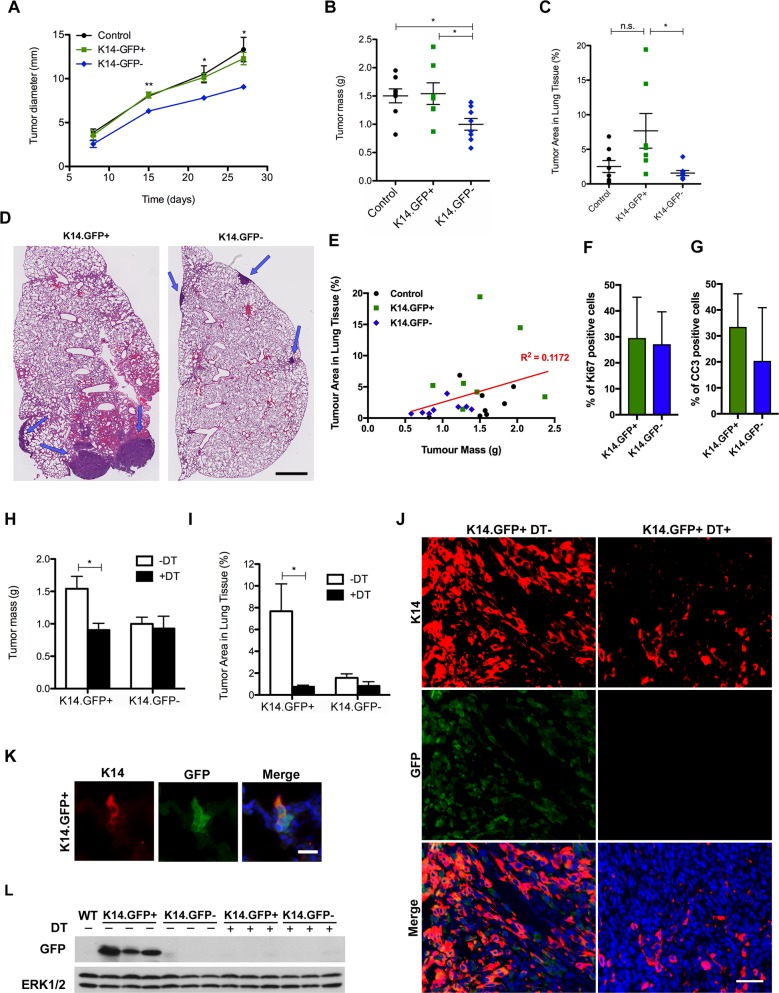
K14.GFP+ cells have greater metastatic potential that K14.GFP− cells in vivo.(A) Primary tumor diameters from mice injected with 4T1 control, or K14.GFP reporter cell lines (K14.GFP+ or K14.GFP−), measured over the course of the experiment. n = 8 (control), 7 (K14.GFP+), and 8 (K14.GFP−); *p < 0.05, **p < 0.001 by one-way ANOVA followed by Newman-Keuls multiple comparisons posttest. (B) Final tumor masses measured after mice were euthanized. (C) Lung metastases were quantified by measuring the average percent area of lung tissue occupied by the tumor in 5 sections (5-μm thick) cut at 200-μm intervals. (D) Representative images of H&E-stained lung sections containing metastases from mice injected with K14.GFP+ or K14.GFP− cell lines. Arrows indicate metastasis; scale bar 1 mm. (E) Correlation analysis of primary tumor mass and lung metastasis. Scatter plot of the percent tumor area in lung tissue compared to the primary tumor mass for each mouse analyzed (n = 23). The slope does not significantly differ from zero by linear regression analysis (p = 0.1097). Quantification of percent of positive cells for Ki67 (F) and CC3 (G) in tumors from K14.GFP+ and K14.GFP− cells. Shown are means ± SD of quantifications of whole tumor sections. (H) Final tumor masses measured after mice were euthanized. For DT treatment, the mice were injected i.p. with DT (25 mg/kg) on days 7, 9, 11, and 13. n = 7 (K14.GFP+; no DT), 4 (K14.GFP+; with DT), 8 (K14.GFP−; no DT), and 4 (K14.GFP−; with DT). p = 0.0425 by unpaired t test. (I) Lung metastases were quantified for the mice described in H. Statistical analysis for (B), (C), and (I) was calculated by one-way ANOVA followed by Tukey’s multiple comparisons posttest; *p < 0.05 or n.s. (J) Fluorescent IHC was performed for K14 and GFP on primary tumors generated from K14.GFP+ cell lines either DT− or DT treated (“DT+”) as described in (H); scale bar 40 μm. (K) Same staining as described in J was carried out on metastatic lung of K14.GFP+-injected mice; scale bar 20 μm. (L) Immunoblots of lysates from primary tumors were analyzed for GFP expression. Every lane represents a different tumor. Blots were also probed with antibodies for ERK1/2 as loading control. If not otherwise indicated, all graphs show mean ± SEM. DT, diphtheria toxin; ERK1/2, extracellular signal-regulated kinase 1/2; GFP, green fluorescent protein; H&E, hematoxylin and eosin; IHC, immunohistochemistry; i.p., intraperitoneally; K, cytokeratin; n.s., not significant